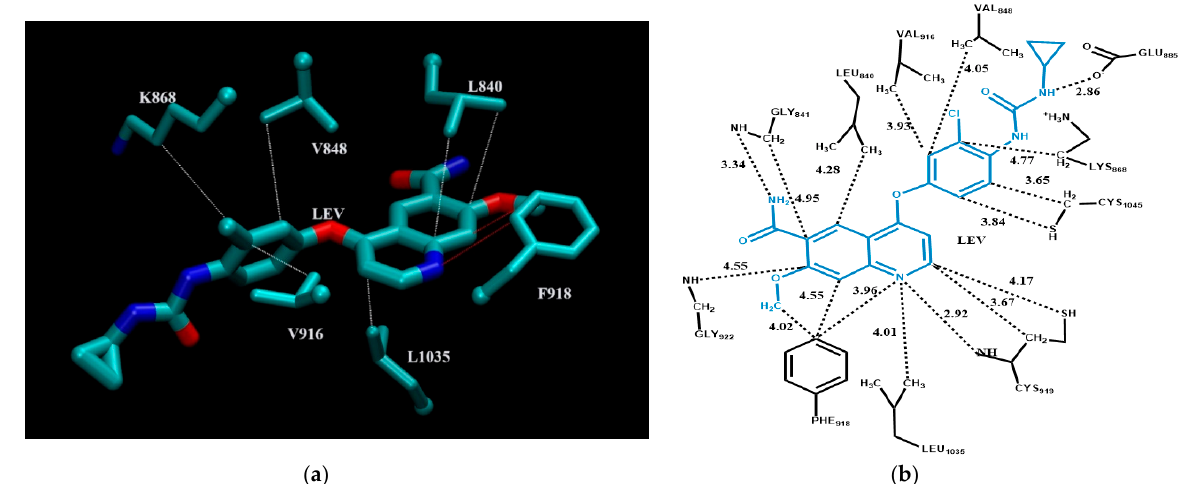
Figure 5. Modes of intermolecular interactions between lenvatinib and its interacting residues in vascular endothelial growth factor receptor 2. ( a ) Structure of residues (in licorice representation, with the a-carbon displayed as a sphere) that are involved in π – π stacking interactions and CH– π interactions with lenvatinib (Ligand ID: LEV) based on the 1.57 Å resolution X-ray crystal structure (PDB ID: 3WZD [51]). Dashed lines indicate the closest interatomic distance (color code: π – π stacking interactions in red, CH– π interactions in white). The structure was generated with the program VMD [59]. ( b ) A schematic intermolecular interaction map between lenvatinib and its interacting residues, with dashed lines indicating interatomic distances in Å.